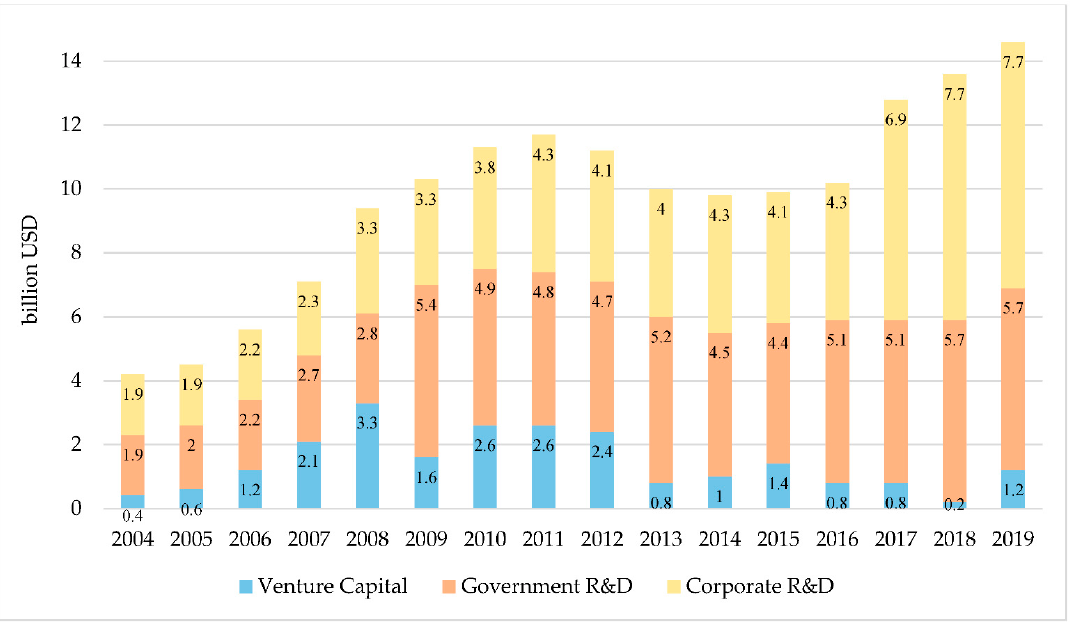
Figure 3. Global new renewable energy investment in technology development by type of investor from 2004 to 2019 (based on [50], p. 62).